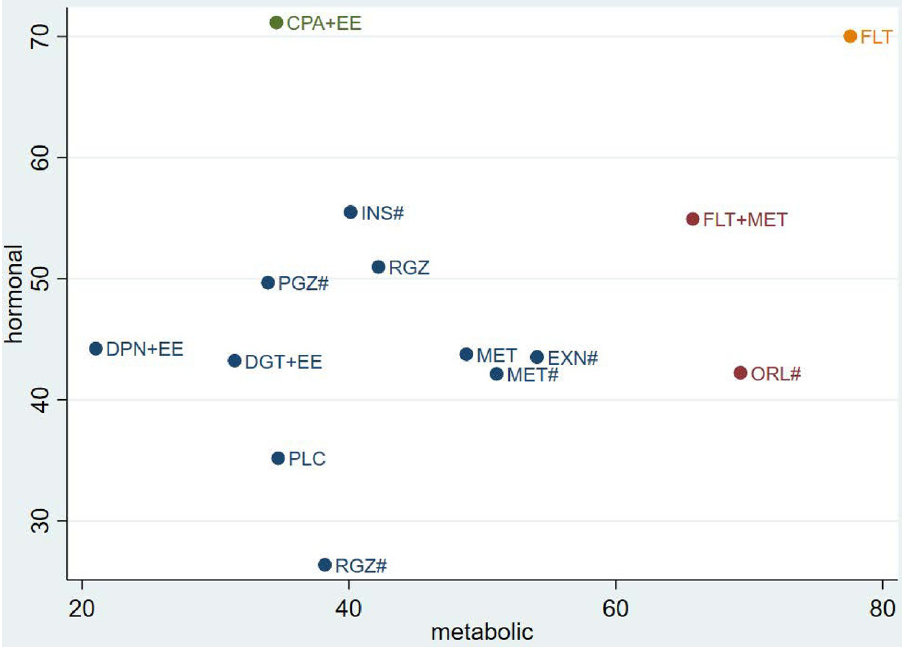
Fig 4. A rankogram show the cumulative ranking of the average SUCRA values for each intervention across all metabolic and hormonal parameters.